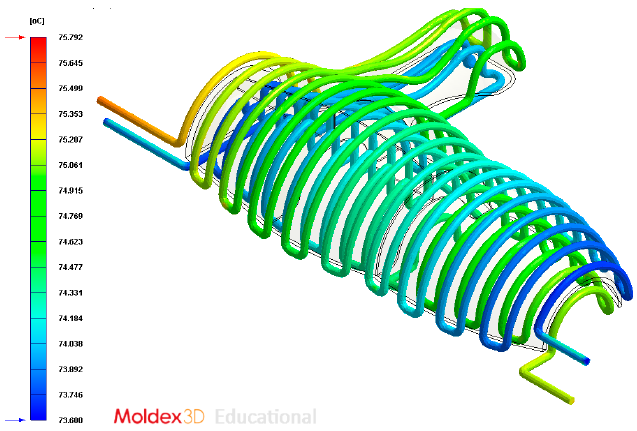
◦ C) of the coolant along the conformal cooling system, Case Figure 22. Temperature (°C) of the coolant along the conformal cooling system, Case B. Figure 22. Temperature ( Figure 22. Temperature (°C) of the coolant along the conformal cooling system, Case B. Figure 22. Temperature (°C) of the coolant along the conformal cooling system, Case B.